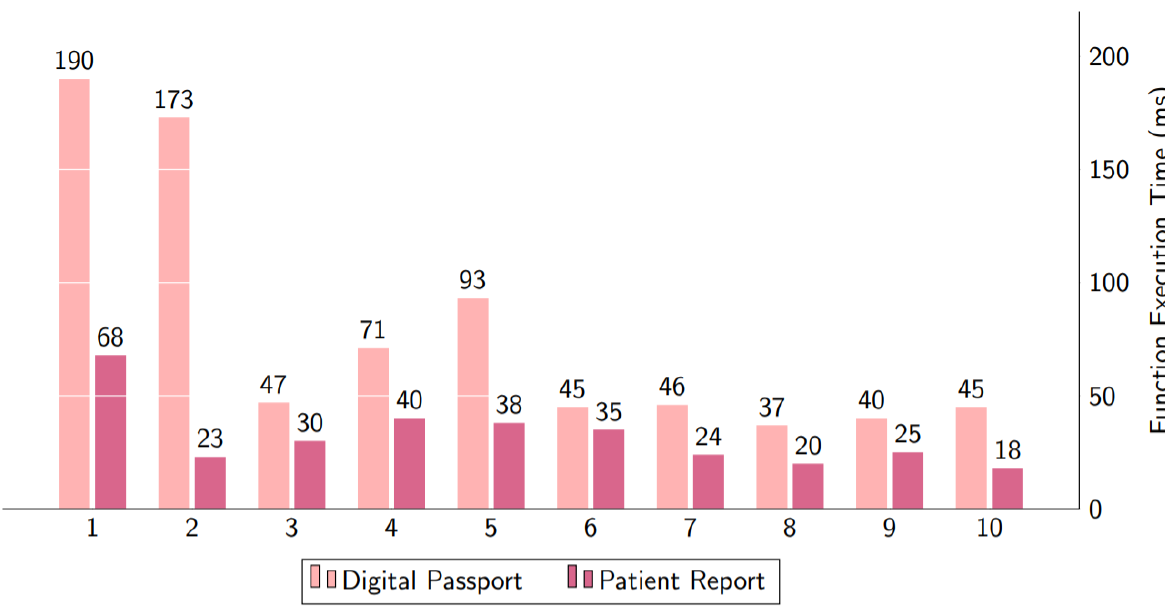
Figure 13. The computational time for accessing data from IPFS and Blockchain.